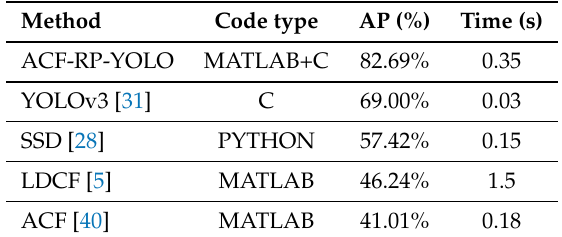
Table 3. Comparison with other popular detection methods.